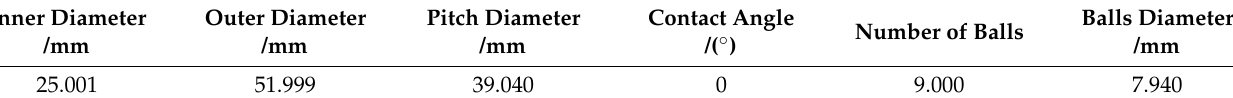
Figure 5. The experimental equipment.